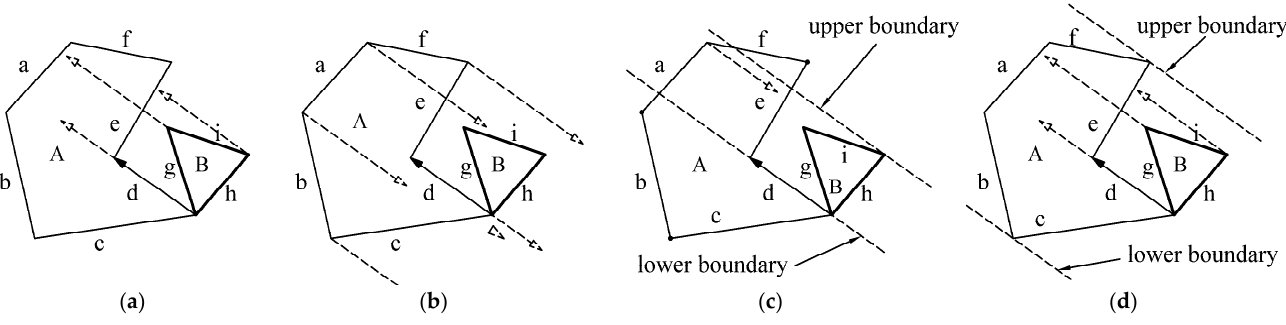
Figure 10. Illustration of shortening the translation vector and the “point exclusion” strategy. ( a ) Projection of the vertices of polygon B ; ( b ) Projection of the vertices of polygon A ; ( c ) Boundary of polygon A ; ( d ) Boundary of polygon B .